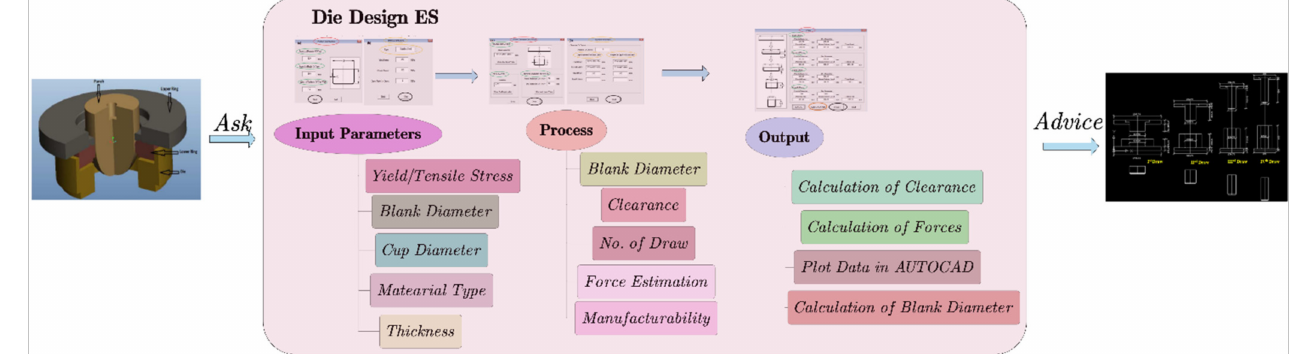
Figure 13. An ES of die design for multi-stage deep drawing process